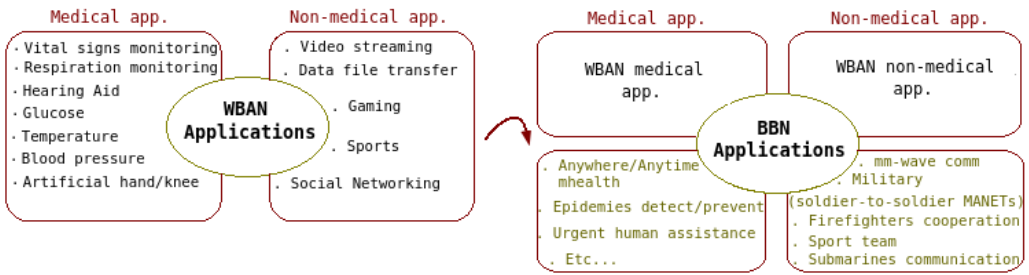
Figure 3. Application area extension from WBAN to body-to-body networks